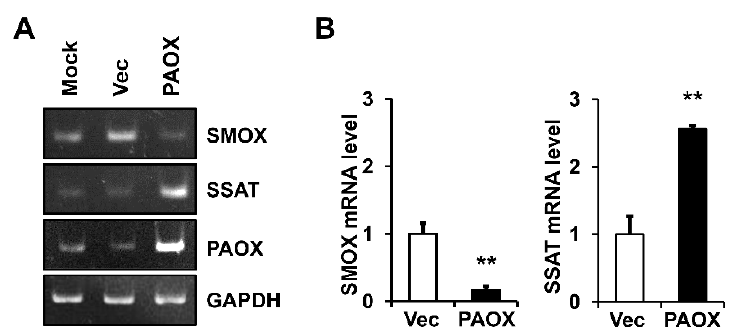
Figure 5. Effect of PAOX expression on spermine oxidase ( SMOX ) and spermidine/spermine N 1 -acetyltransferase ( SSAT ) mRNA levels in fibroblasts. Fibroblasts mock-infected or infected with vector viruses or PAOX viruses were incubated in a serum-free DMEM for 12 h. The levels of SMOX , SSAT , PAOX , and GAPDH mRNAs were assessed using ( A ) conventional and ( B ) real-time RT-PCR analyses. Graphs depict the relative levels of SMOX and SSAT mRNAs versus vector-infected cells using real-time RT-PCR analysis. Each value represents the mean ± standard deviation of three independent experiments. ** p < 0.01 vs. vector control.